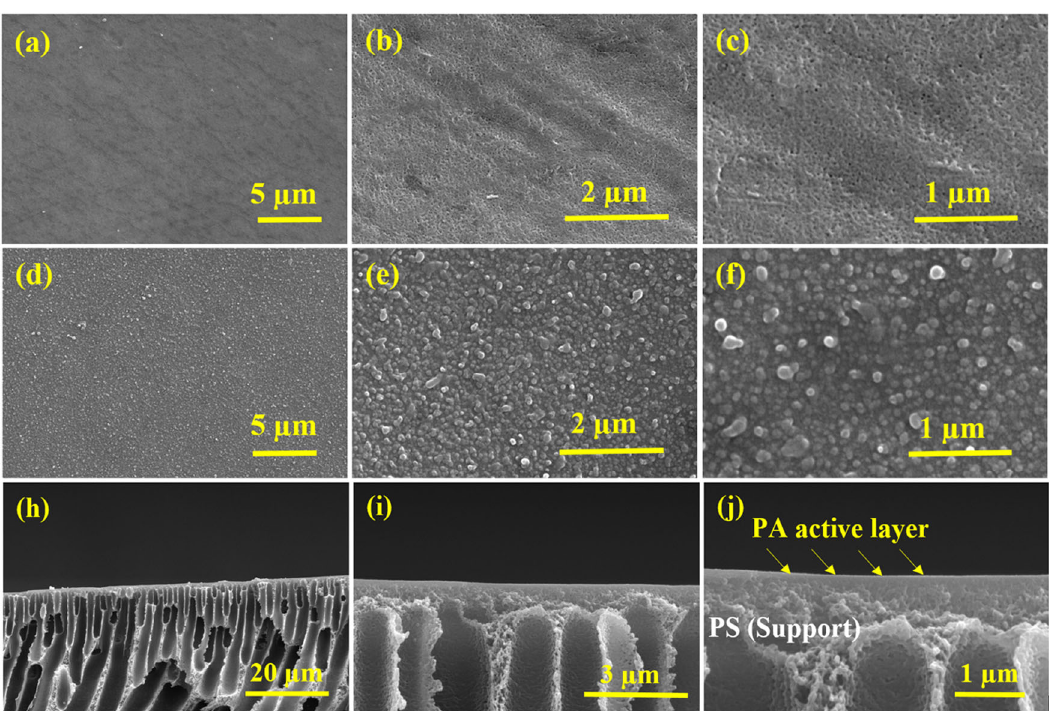
Fig. 3 Morphological analysis of membranes. FE-SEM images of the PS/PET support ( a – c ) and HCPA-TFC-NF@M2 ( d – f ) membranes at three different magni fi cations, h – j cross-sectional images of HCPA-TFC-NF@M2 at different magni fi